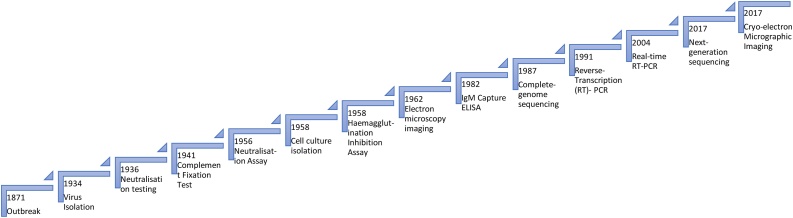
Chronological representation of discoveries related to the detection of Japanese encephalitis virus infection (Miyake, 1964, Sever, 1962, Kuttner and Ts’un, 1936, Casals and Palacios, 1941b, Rose, 1992, Okuno et al., 1975, Casals and Palacios, 1941c, Ravi et al., 1989b).